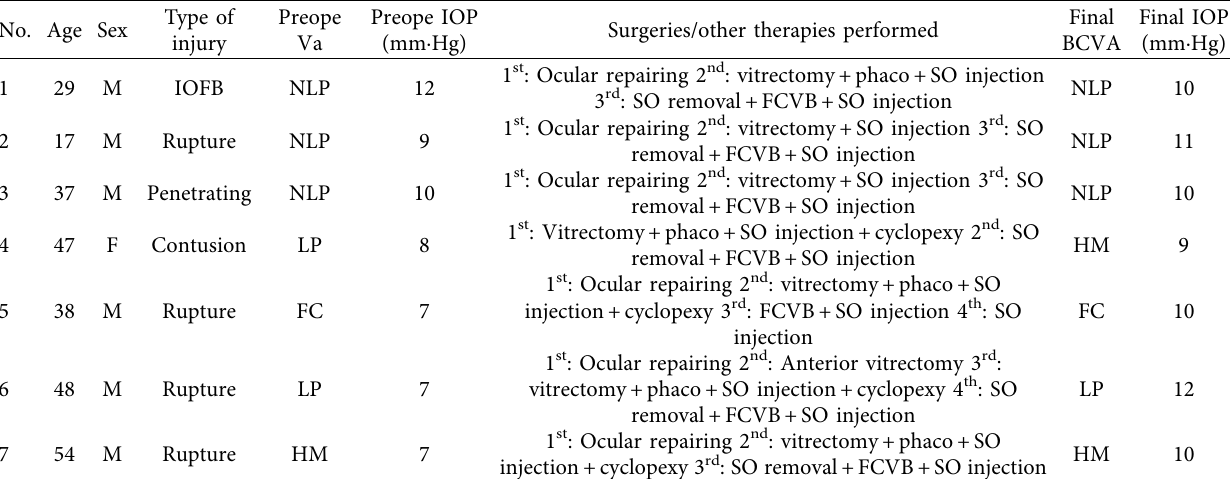
Table 1: Characteristics of 7